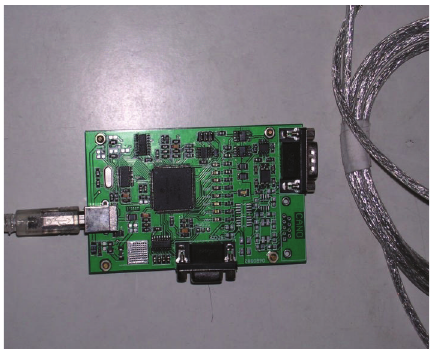
Figure 7: CAN card in the